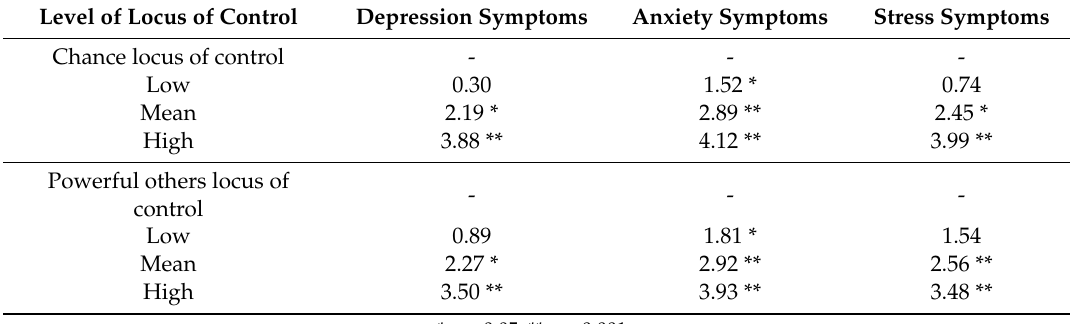
Table 4. The relationship between risk of COVID-19 at di ff erent levels of external locus of control.